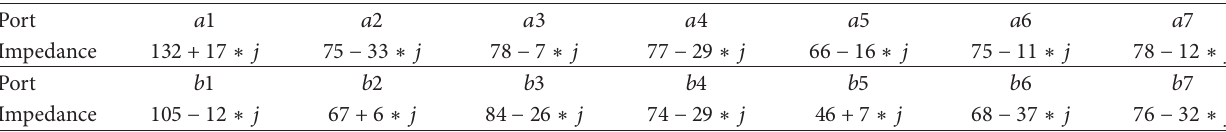
Table 1: Measured input impedance of each